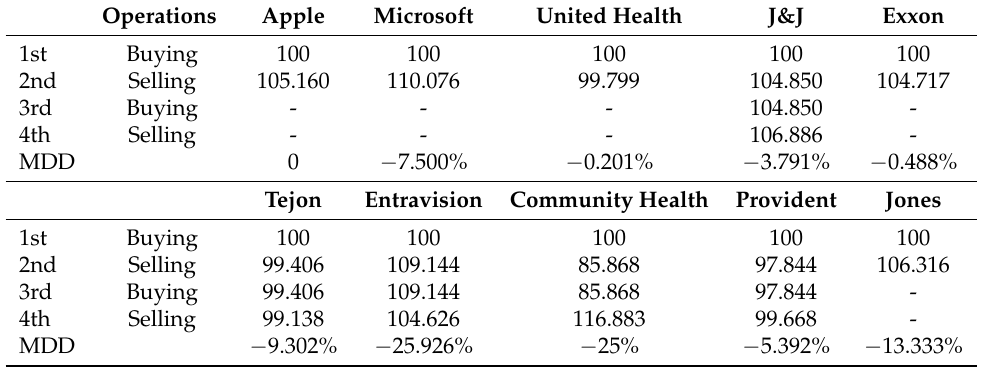
Table 7. Gross performances for a TI-SiSS trading strategy for the most/least capitalized